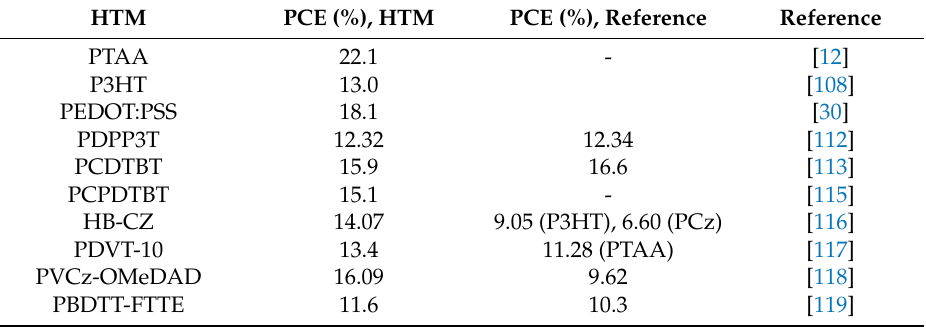
Table 2. Overview of the photovoltaic performance (PCE) of the polymeric HTMs presented in this work. For comparison, the performance of reference cells fabricated under identical conditions is also shown. When not otherwise specified, the reference HTM is spiro-OMeTAD. For some polymers (hyper-branched carbazole-based polymer (HB-CZ) and PDVT-10), a different HTM is used for comparison, as indicated in paren